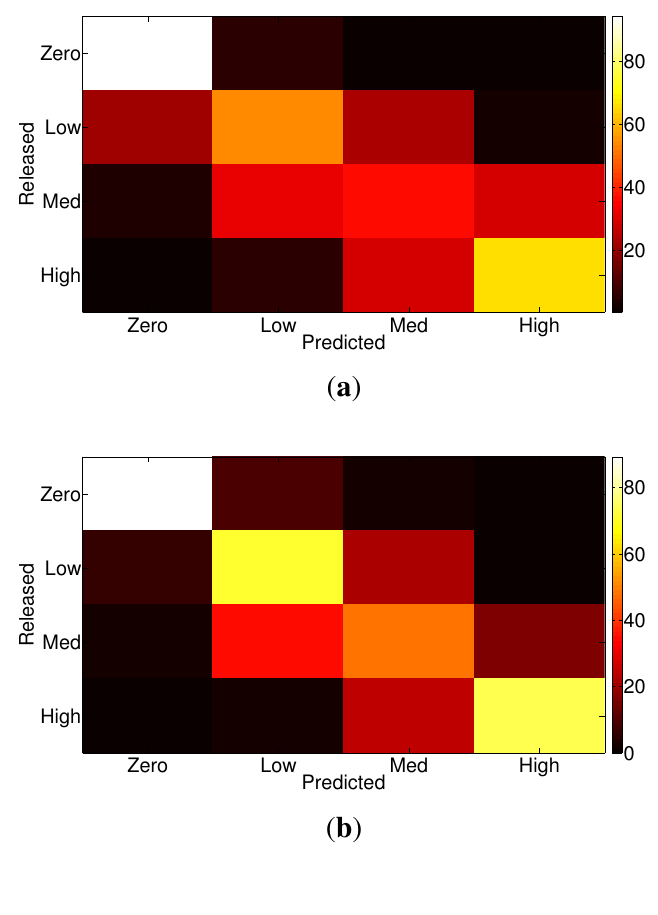
Figure 7. Confusion matrix (in %) to discriminate different ethylene concentration levels. ( a ) Balanced training dataset. ( b ) Using all available samples for